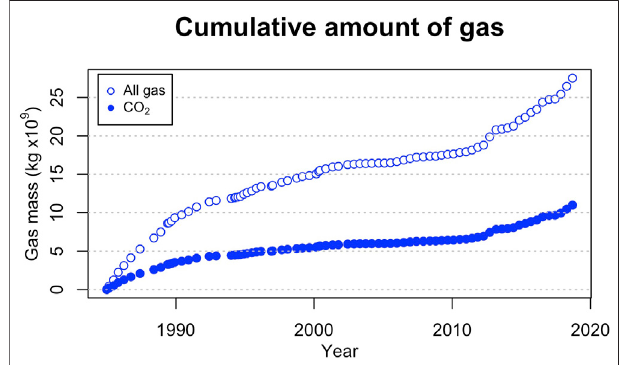
FIGURE 10 | Cumulative amount of gas transited through the hydrothermal system since 1985 (both leaving and entering the reservoir). Open symbols refer to all gas, solid symbol to CO 2